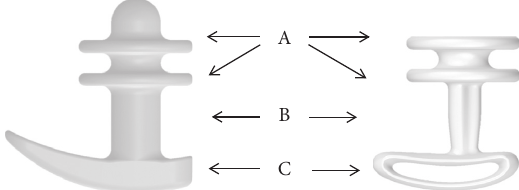
Figure 1: Investigational device, size 30mm. Left: the design used in the clinical investigation; right: the design used in the postmarket studies. A � support rings, B � midsection, and C �